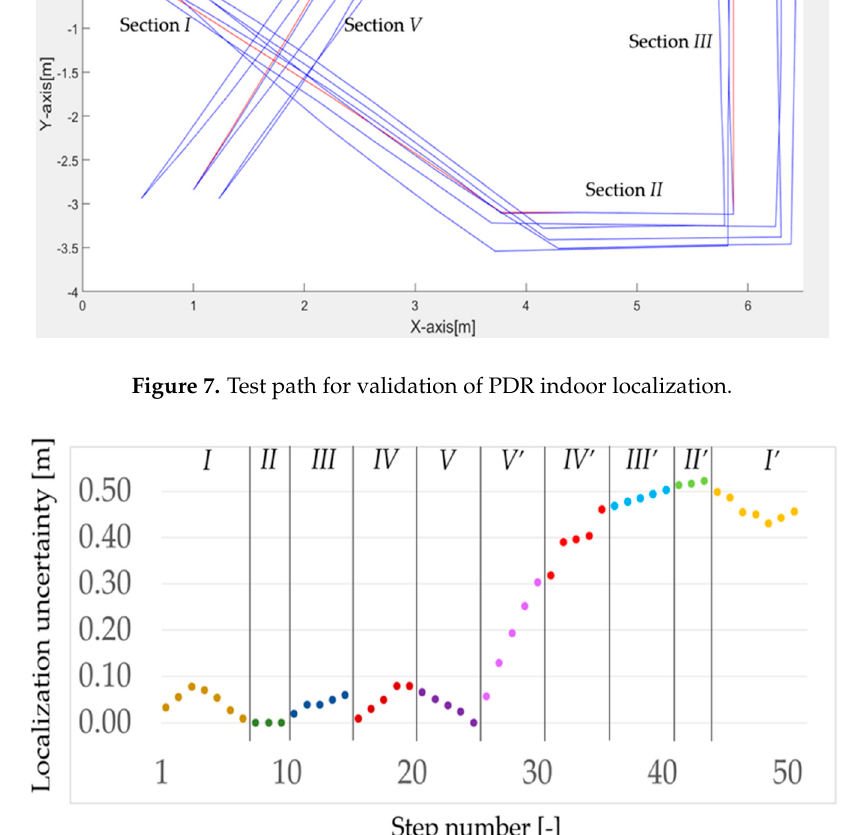
Figure 8. PDR indoor localization uncertainty for each step of the first round of the test path from the start to the end points and in the reverse direction.